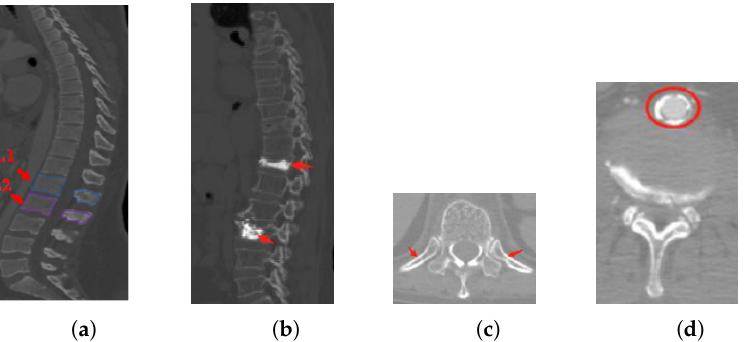
Figure 1. The challenges of vertebrae segmentation. ( a ) Inter-class similarity. ( b ) Unhealthy vertebrae. ( c , d ) Interference